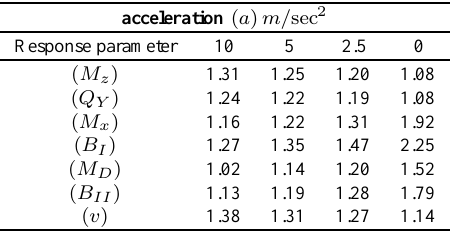
Table 12 Effect of acceleration of vehicle on impact